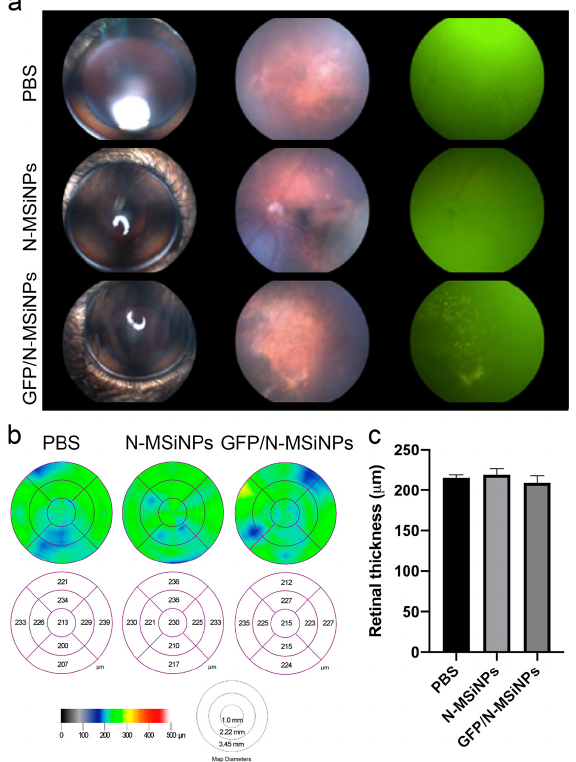
Figure 3. Morphological evaluation of mouse eyes three months after subretinal injection of 1 µL PBS, empty nanoparticles (N-MSiNPs), or nanoparticles loaded with the pEGFP-N1 plasmid (GFP/N-MSiNPs). ( a ) External aspect of the cornea (left column), eye fundus in the visible spectrum (central column), and fluorescent spectrum (right column). ( b ) OCT images showing the retinal thickness are represented as a colorimetric scale in the retinal maps. ( c ) Quantification of the retinal thickness measured by OCT. Bars in ( c ) represent retinal thickness in µm ± standard error of the mean (SEM).